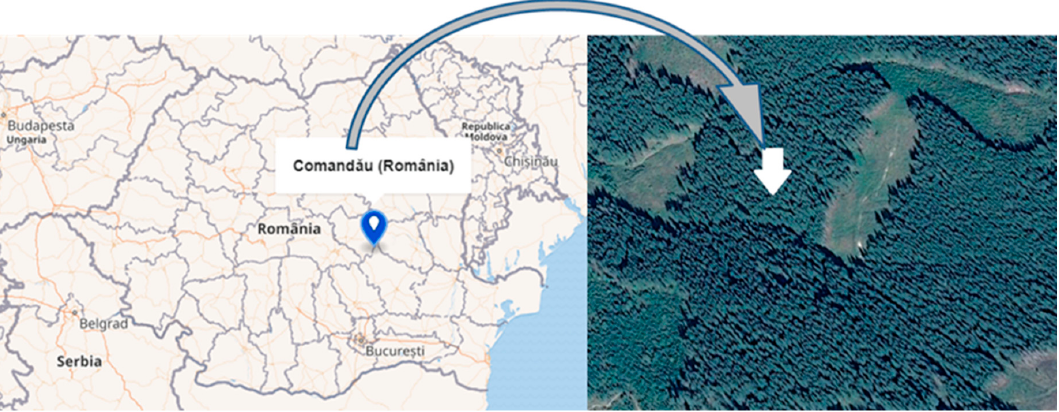
Figure 1. Research venue.